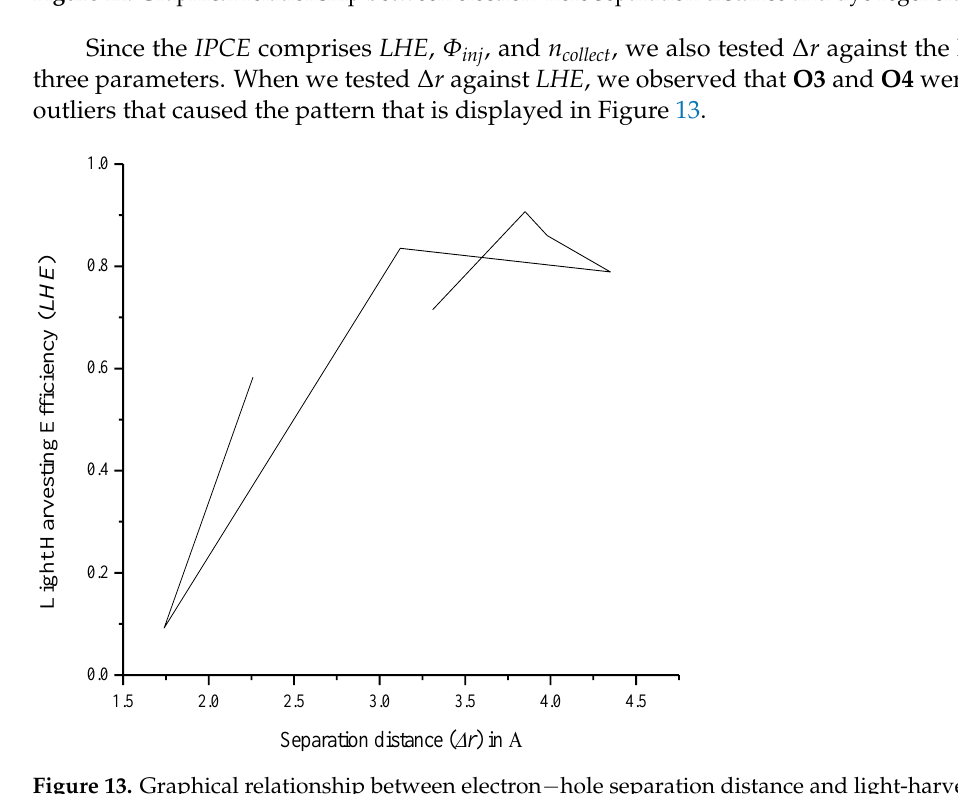
Figure 12. Graphical relationship between electron – hole separation distance and dye regeneration.